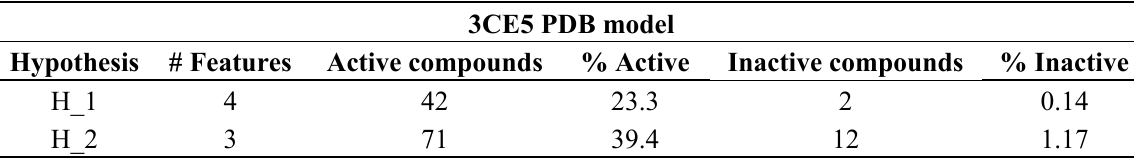
Table 1. Classification of the pharmacophore hypotheses generated by 3CE5 PDB